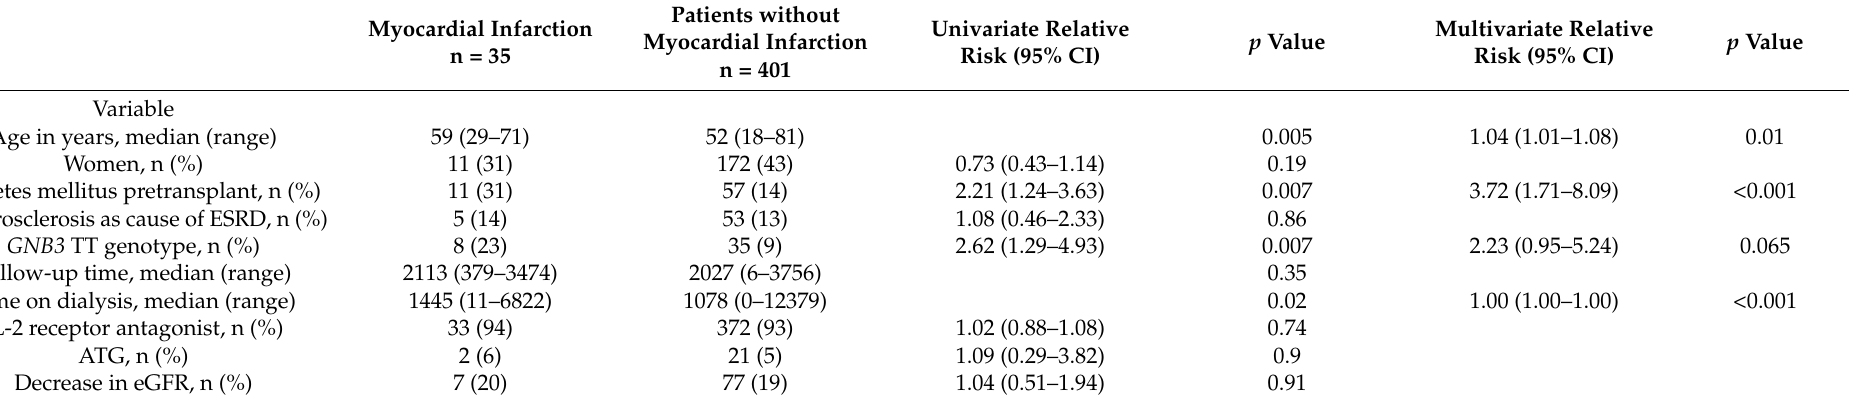
Table 3. Results of univariate and multivariate analyses identifying risk factors for the development of acute myocardial infarction among 436 patients after renal allograft transplant.